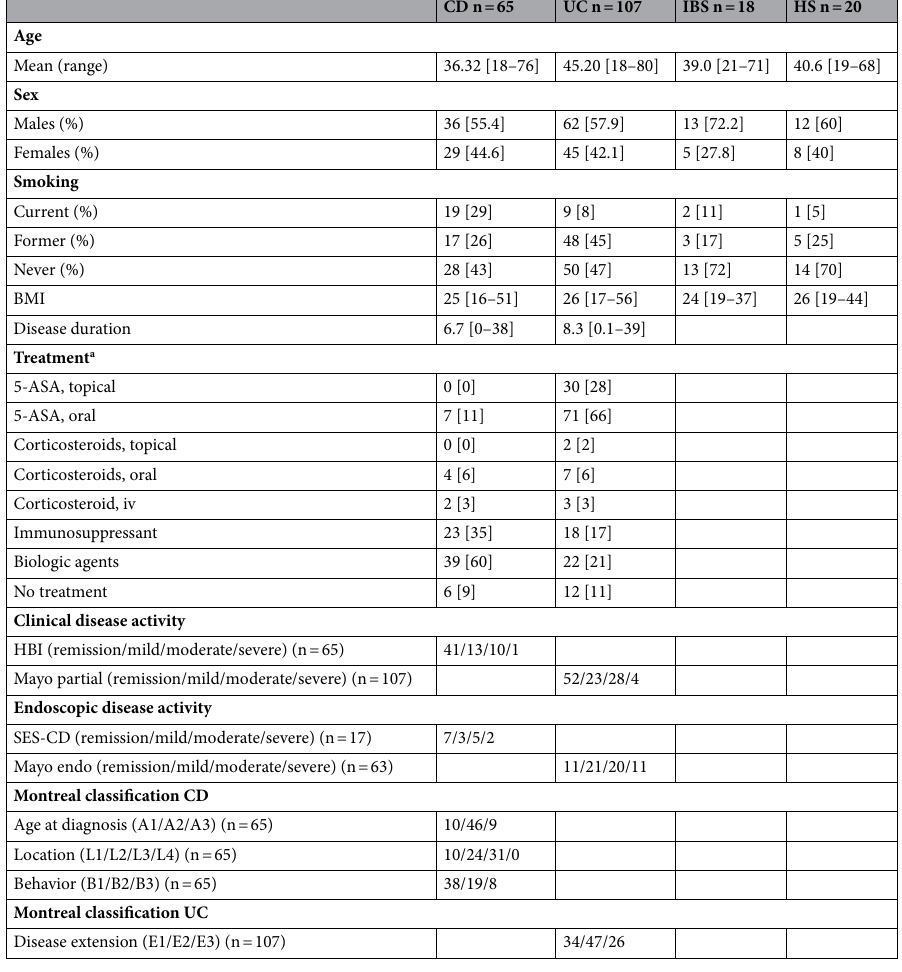
Table 1. Subject characteristics. HBI: remission (< 5), mild (5–7), moderate (8–16), severe (> 16). Mayo partial: remission (< 2), mild (2–4), moderate (5–7), severe (> 7). SES-CD: Simple endoscopic score of Crohn’s colonic, L3: ileocolonic, L4: isolate upper disease. B1: non-stricturing, non-penetrating, B2: stricturing, B3: penetrating. E1: proctitis, E2: Left sided, E3: extensive. CD Crohn’s disease, UC ulcerative colitis, IBS irritable bowel syndrome, HS healthy subjects. a Some patients received more than one